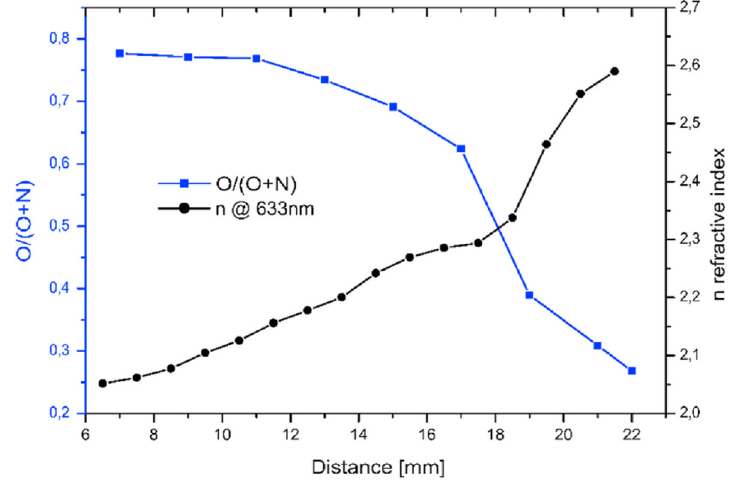
Figure 15. Variation in both oxygen and nitrogen composition ( ■ ) and refractive index ( • ) vs. dis ‐ tance along the combinatorial HfON layer RF sputtered in Ar ‐ O ‐ N plasma gas with gradual oxygen depletion. O/O + N ratio revealed by EDS ( ■ ); corresponding refractive index revealed by ellipsom ‐ etry at 632.8 nm wavelength ( • ). Reproduced with permission from [63]. Copyright © 2020, Elsevier.